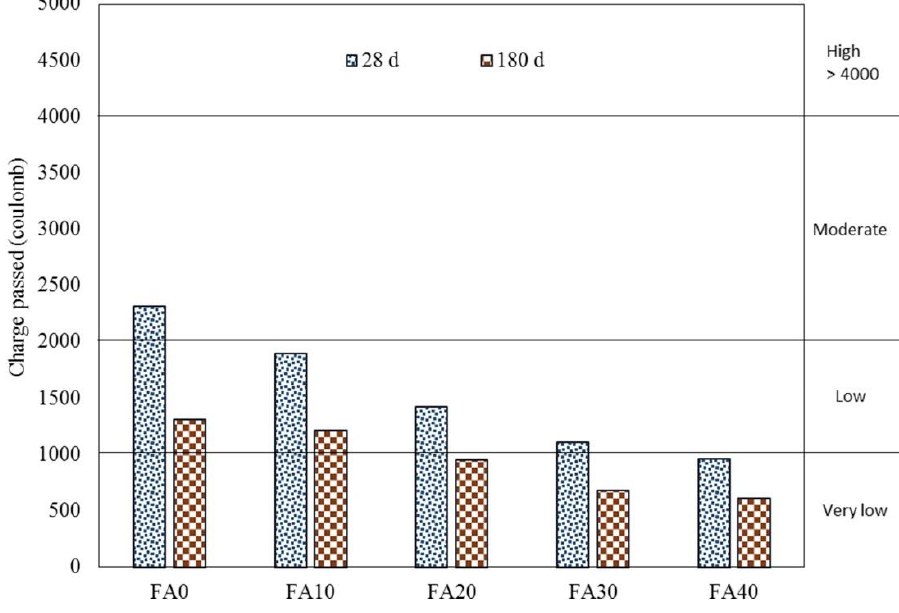
Figure 5. Chloride penetration of fly ash based-concrete at 28 and 180 days of curing